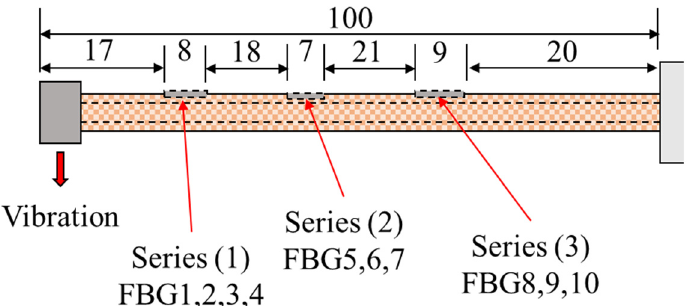
Figure 20. The position of FBGs in the series setup of the pipe.